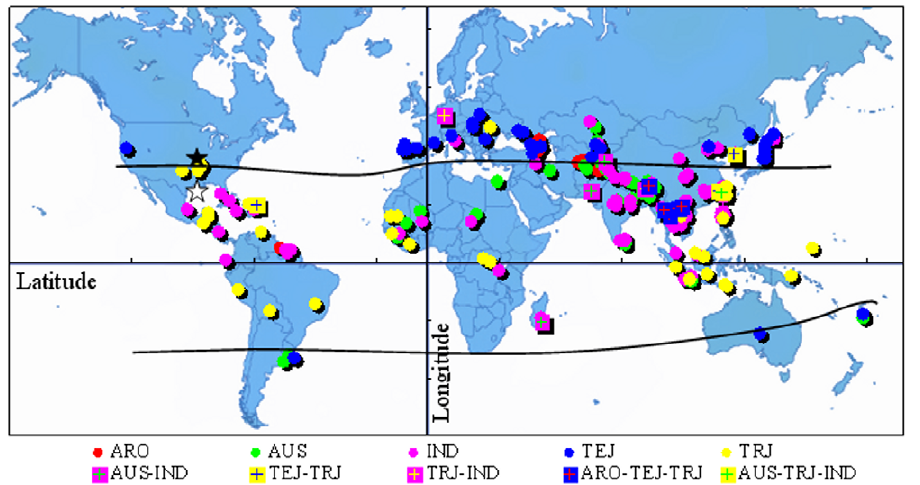
Figure 2. Geographic distribution of 203 accessions based on their latitude and longitude. ARO: Aromatic ; AUS: aus ; IND: Indica ; TRJ: Tropical japonica ; TEJ: Temperate japonica ; ARO-TEJ-TRJ: admixture of ARO with TEJ and TRJ; AUS-IND: admixture of AUS with IND; AUS-TRJ-IND: admixture of AUS with TRJ and IND; TEJ-TRJ: admixture of TEJ with TRJ and TRJ-IND: admixture of TRJ with IND. w : Stuttgart AR, q : Beaumont TX.